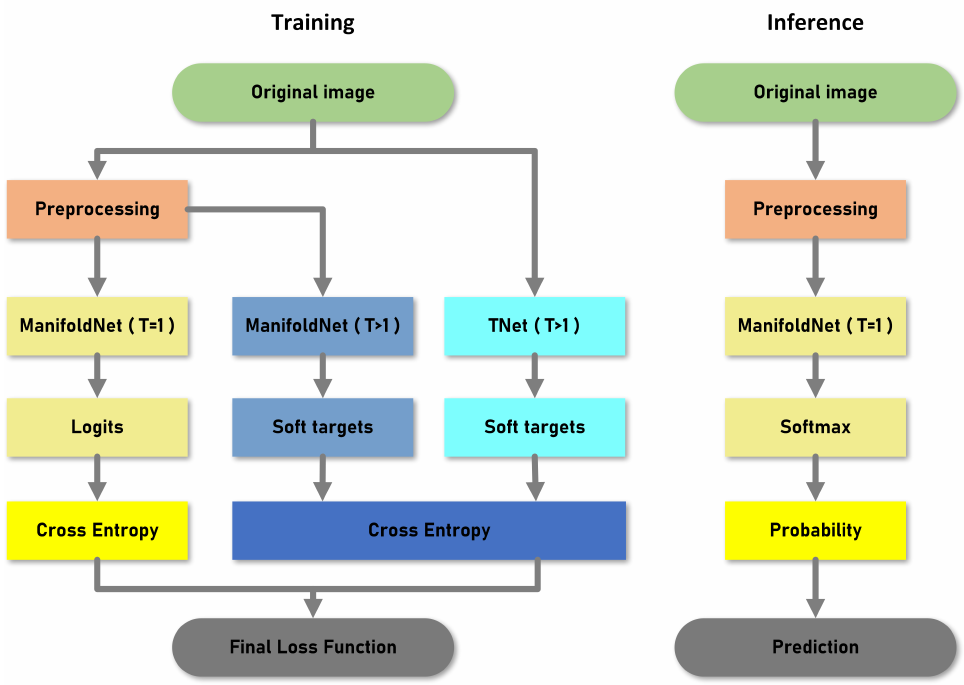
Figure 5. The flow chart of our proposed